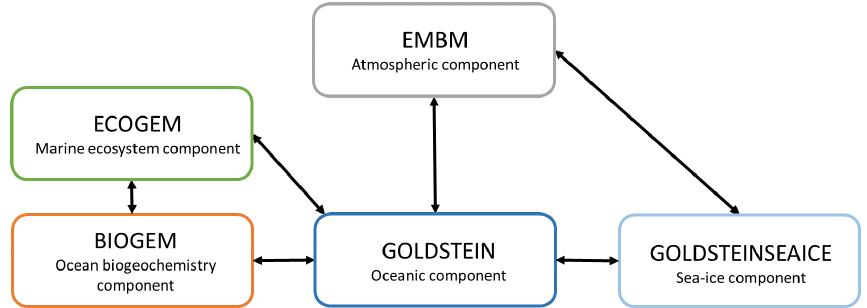
Figure 2. Representation of the components of the EcoGEnIE model. The black arrows indicate the link between the different climatic